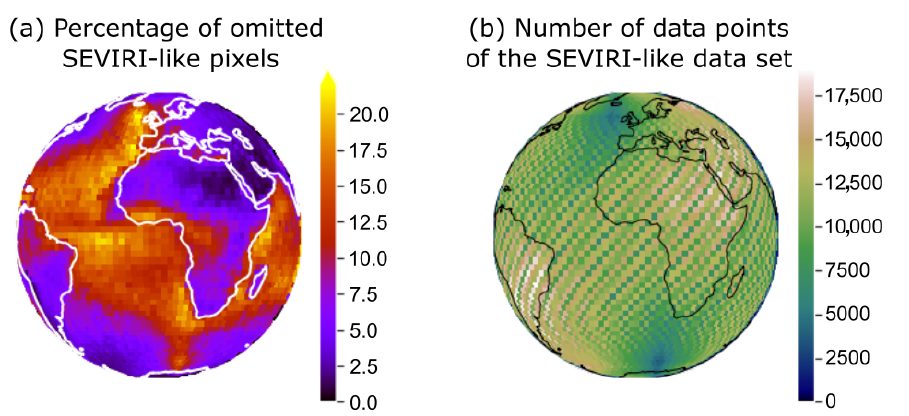
Figure 2. ( a ) Percentage of SEVIRI-like pixels that are omitted due to non-fully covered pixels in SEVIRI resolution or large CTH differences in a SEVIRI pixel; ( b ) Number of data points of the SEVIRI-like CTP data set. Boxes of 2.5 ◦ latitude by 2.5 ◦ longitude are